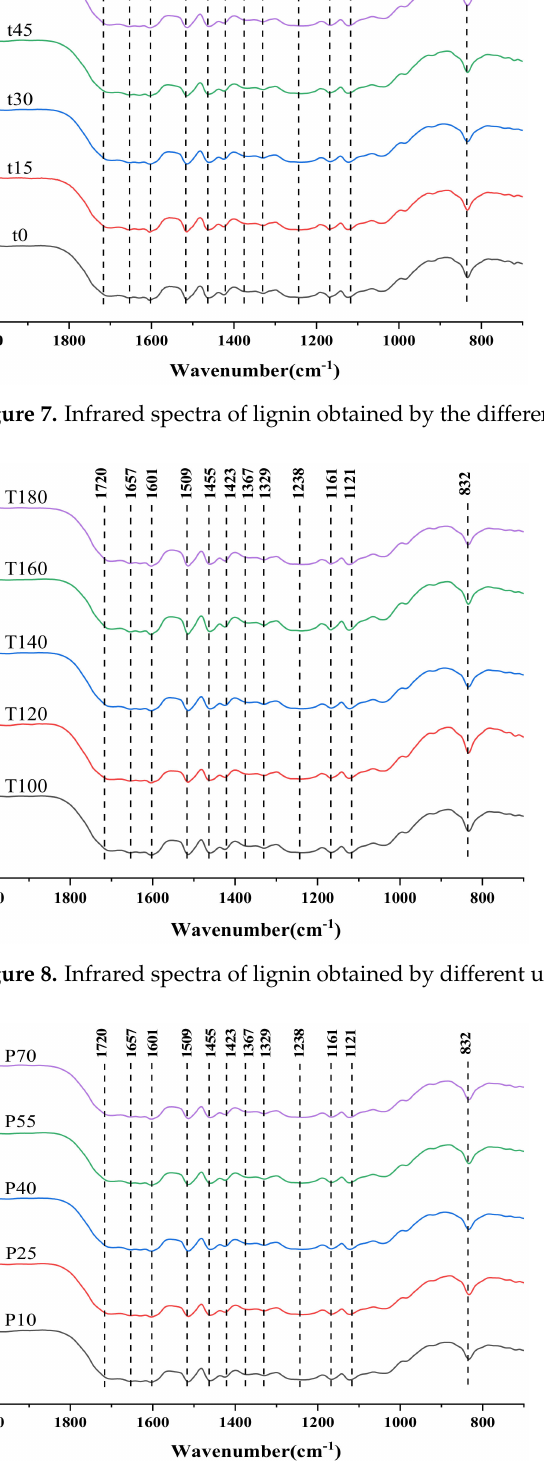
Figure 9. Infrared spectra of lignin obtained by different ultrasonic power